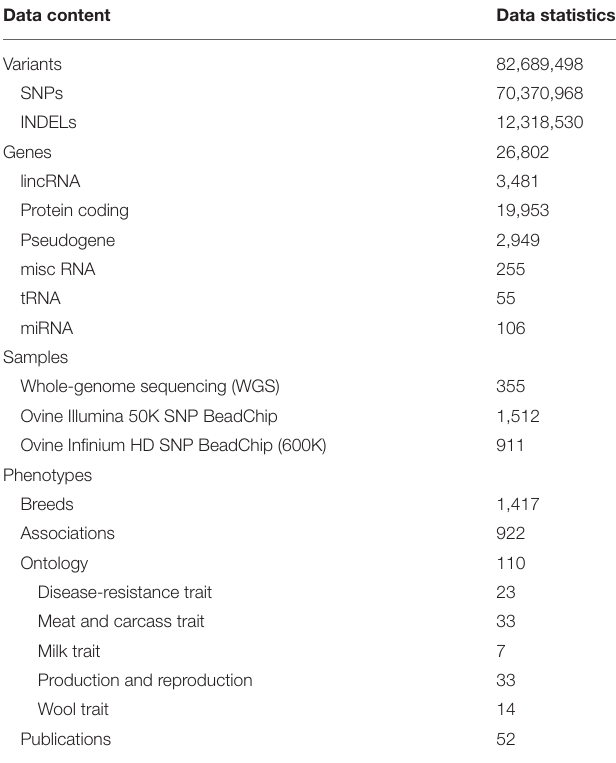
TABLE 1 | Data statistics of